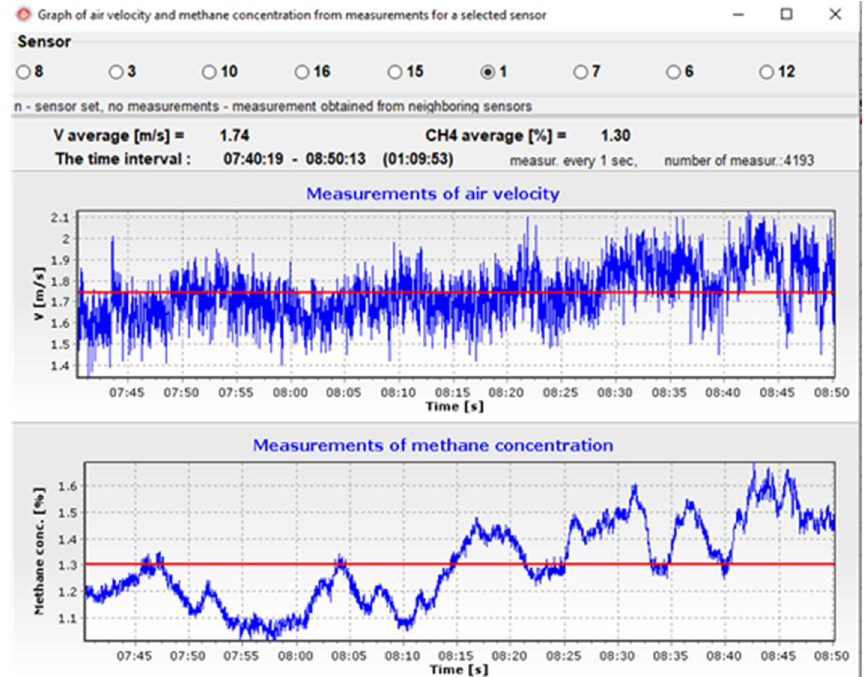
Figure 14. Changes in the air velocity and methane concentration for sensor No 1. between 7:40 and 8:50.